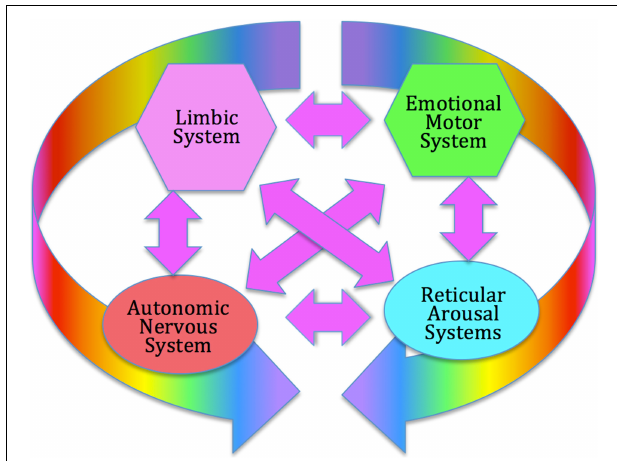
FIGURE 1 | The Core Response Network (CRN). The CRN organizes immediate, instinctive response to environmental challenges, prior to extensive cortical processing. It includes the autonomic nervous system (hypothalamus), the limbic emotional system (amygdala, hippocampus, septal region), the emotional motor system (portions of the basal ganglia, red nucleus, periaqueductal gray), and the reticular arousal systems. All these systems interact strongly through multiple feed-back and feed-forward connections, forming a complex dynamical system which can enter various discrete functional and dysfunctional